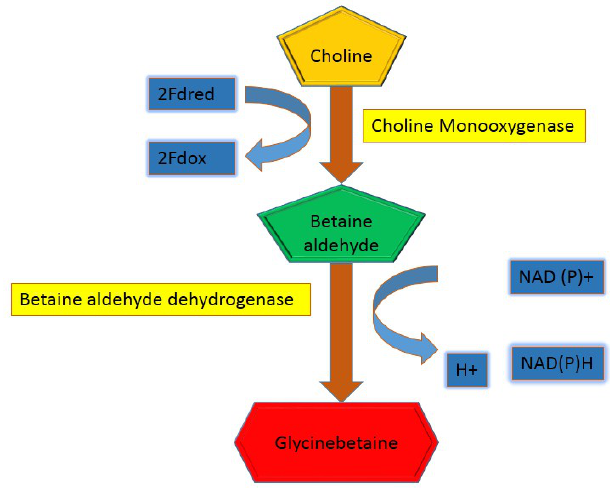
Figure 2. Biosynthesis pathway of glycine betaine in higher plants.